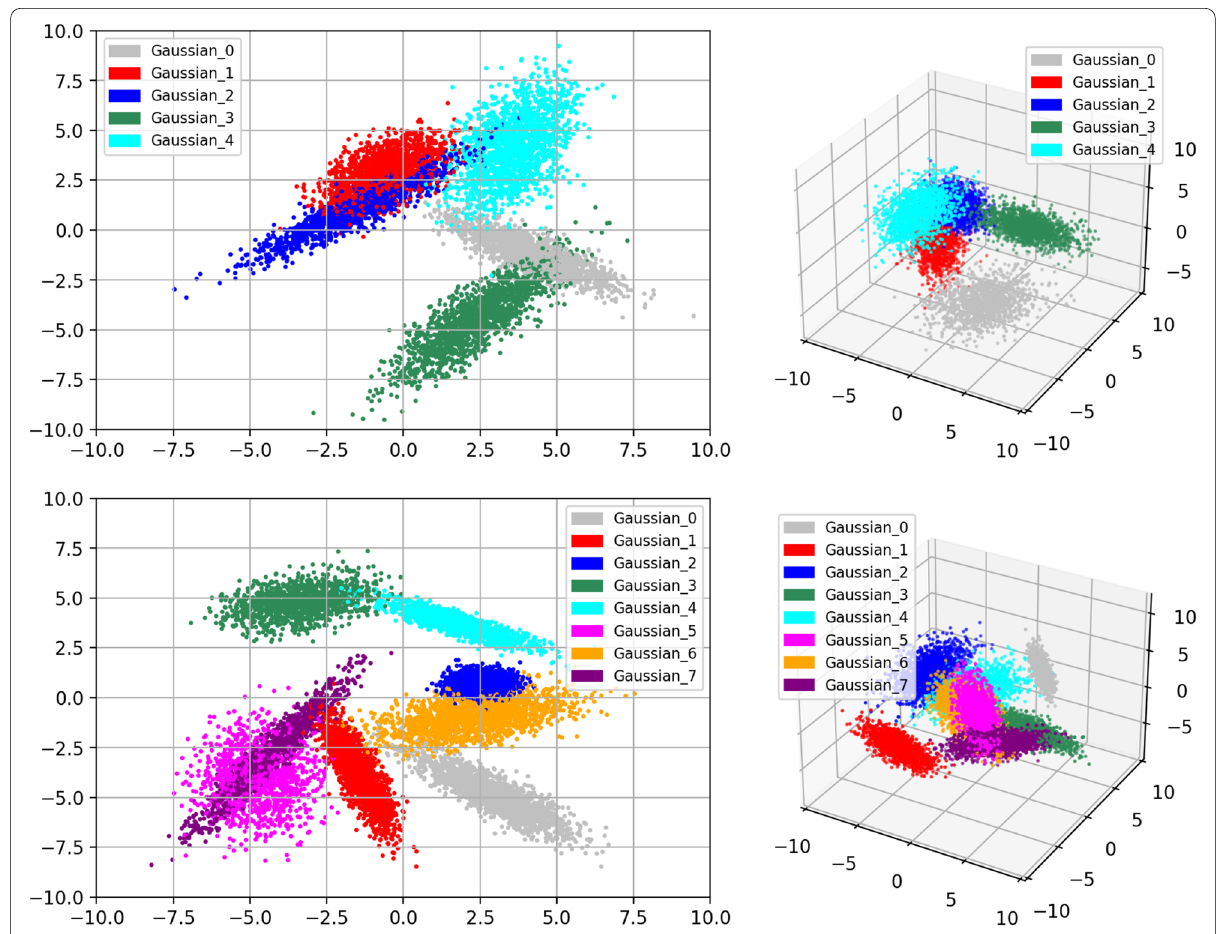
Fig. 8 Typical scatter plots of samples in 2D (left) and 3D (right) spaces with K = 5 (top) and K = 8 (bottom)